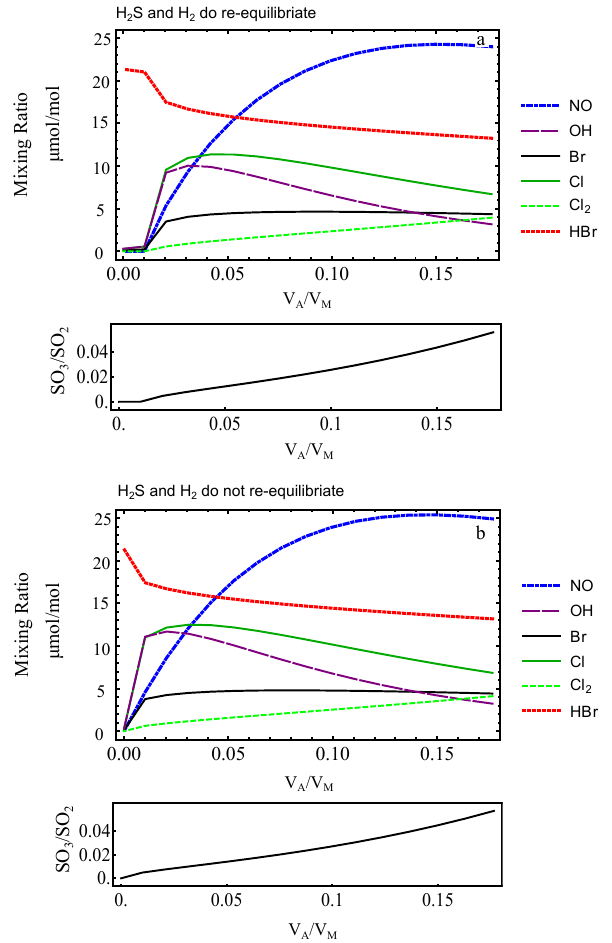
Figure 2. Mixing ratio (10 − 6 molmol − 1 ) of key species (NO, OH, Br, Cl, Cl 2 ) in the HSC output as a function of V A / V M , the assumed magmatic–atmospheric gas ratio in the near-vent plume, ranging from 0 (0.00:1.00) to 0.18 (0.15:0.85). The SO 3 :SO 2 ratios (that prescribe the volcanic sulfate/SO 2 emission) in the HSC output are also shown. (a) Standard operation of HSC in which volcanic H 2 S and H 2 are allowed to re-equilibrate, yielding near-zero mixing ra- tios of these gases in the HSC output. (b) A revised operation of HSC (Martin et al., 2009) in which volcanic H 2 S and H 2 are re- moved (and temporarily replaced by inert Ar) such that they do not re-equilibrate within